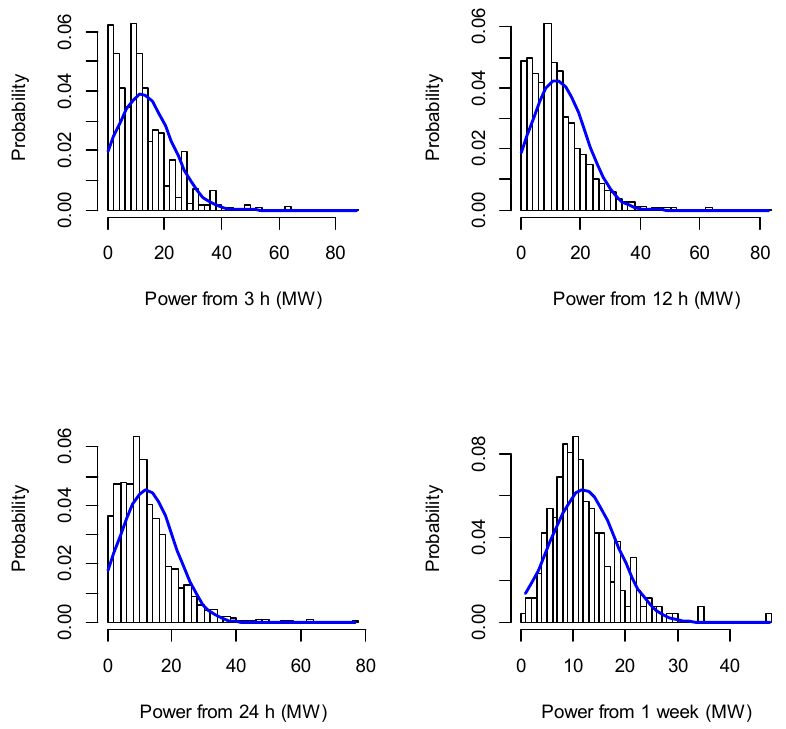
Figure 8. Histogram and pdf of a hybrid wind/wave system generated power from 3 ‐ h to one ‐ week data. Energies 2016 , 9 , 162